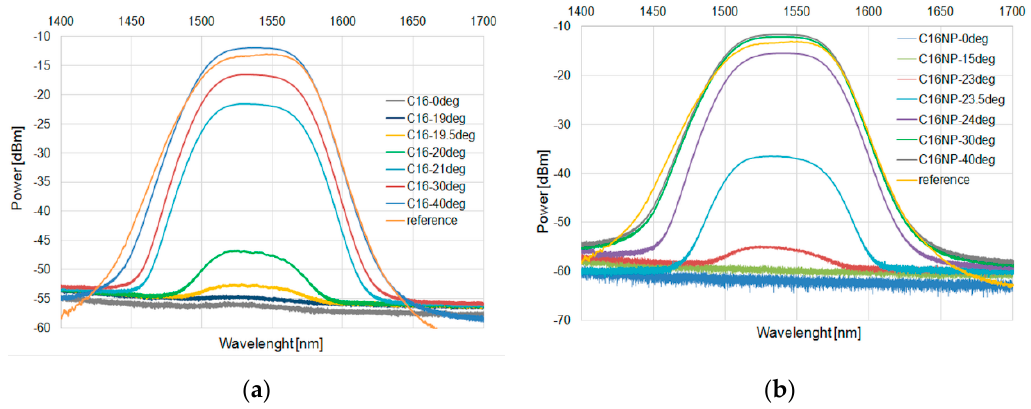
Figure 11. Heating process in C16 ( a ) and with an admixture of NPs ( b ) for SLED 1400–1700 nm.